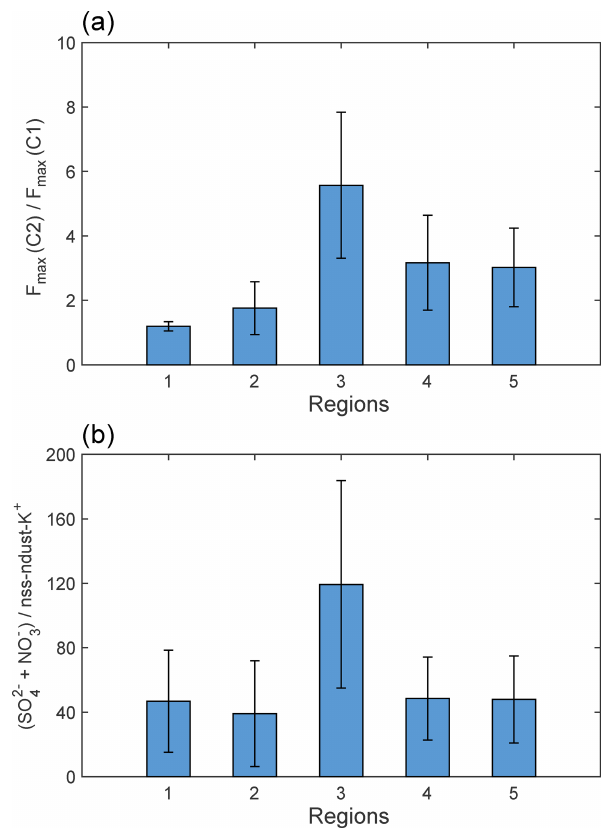
Figure 9. Regional averages of the ratios for (a) F max (C2) and + NO − F max (C1), (b) (SO 2 − ) and nss − ndust − K + 4 3